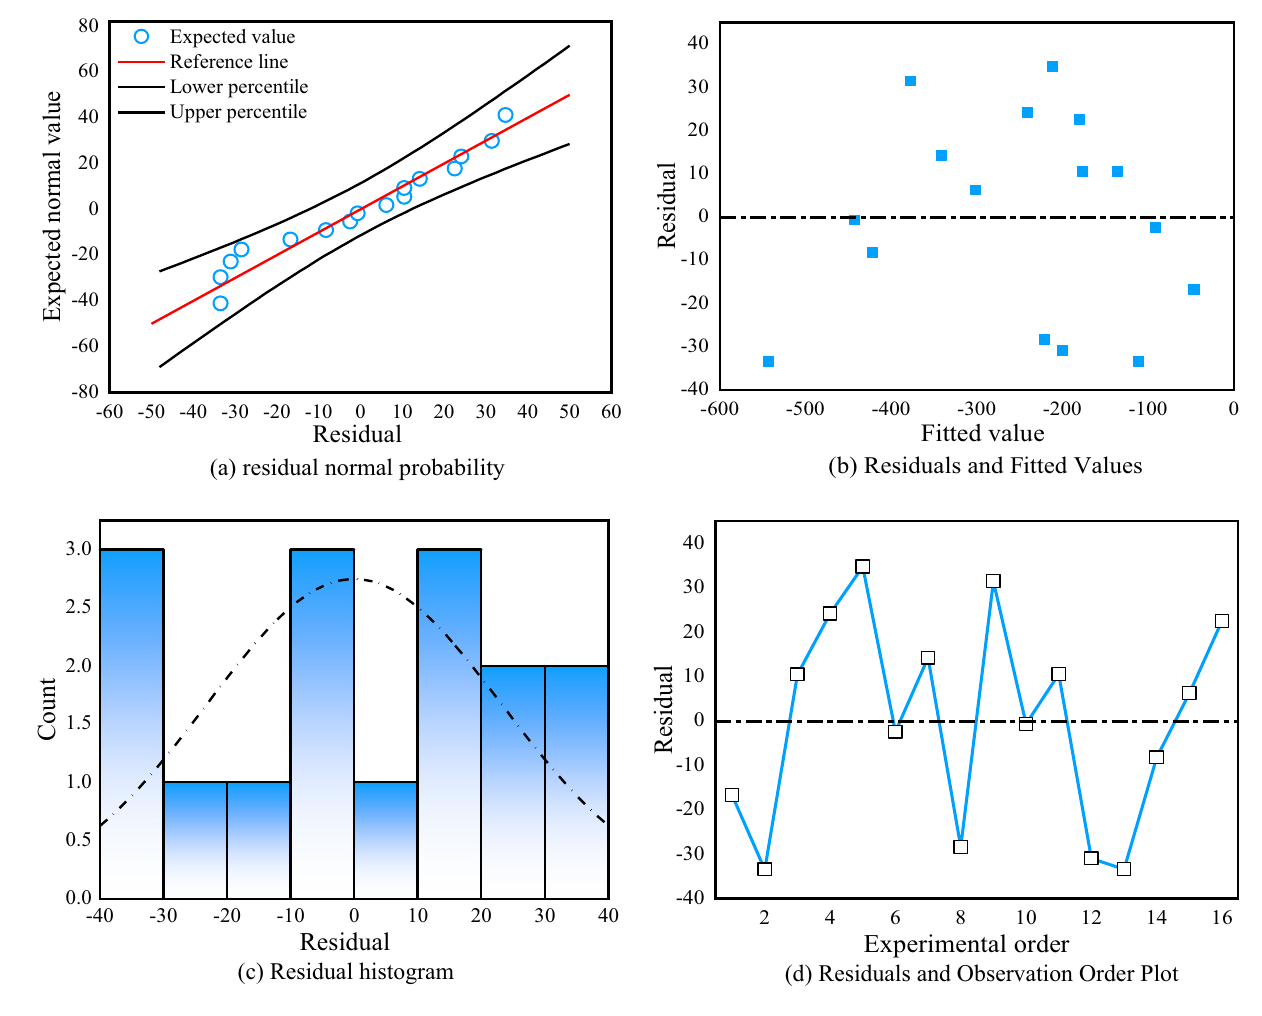
Figure 21. Residual plots of the roof regression model.